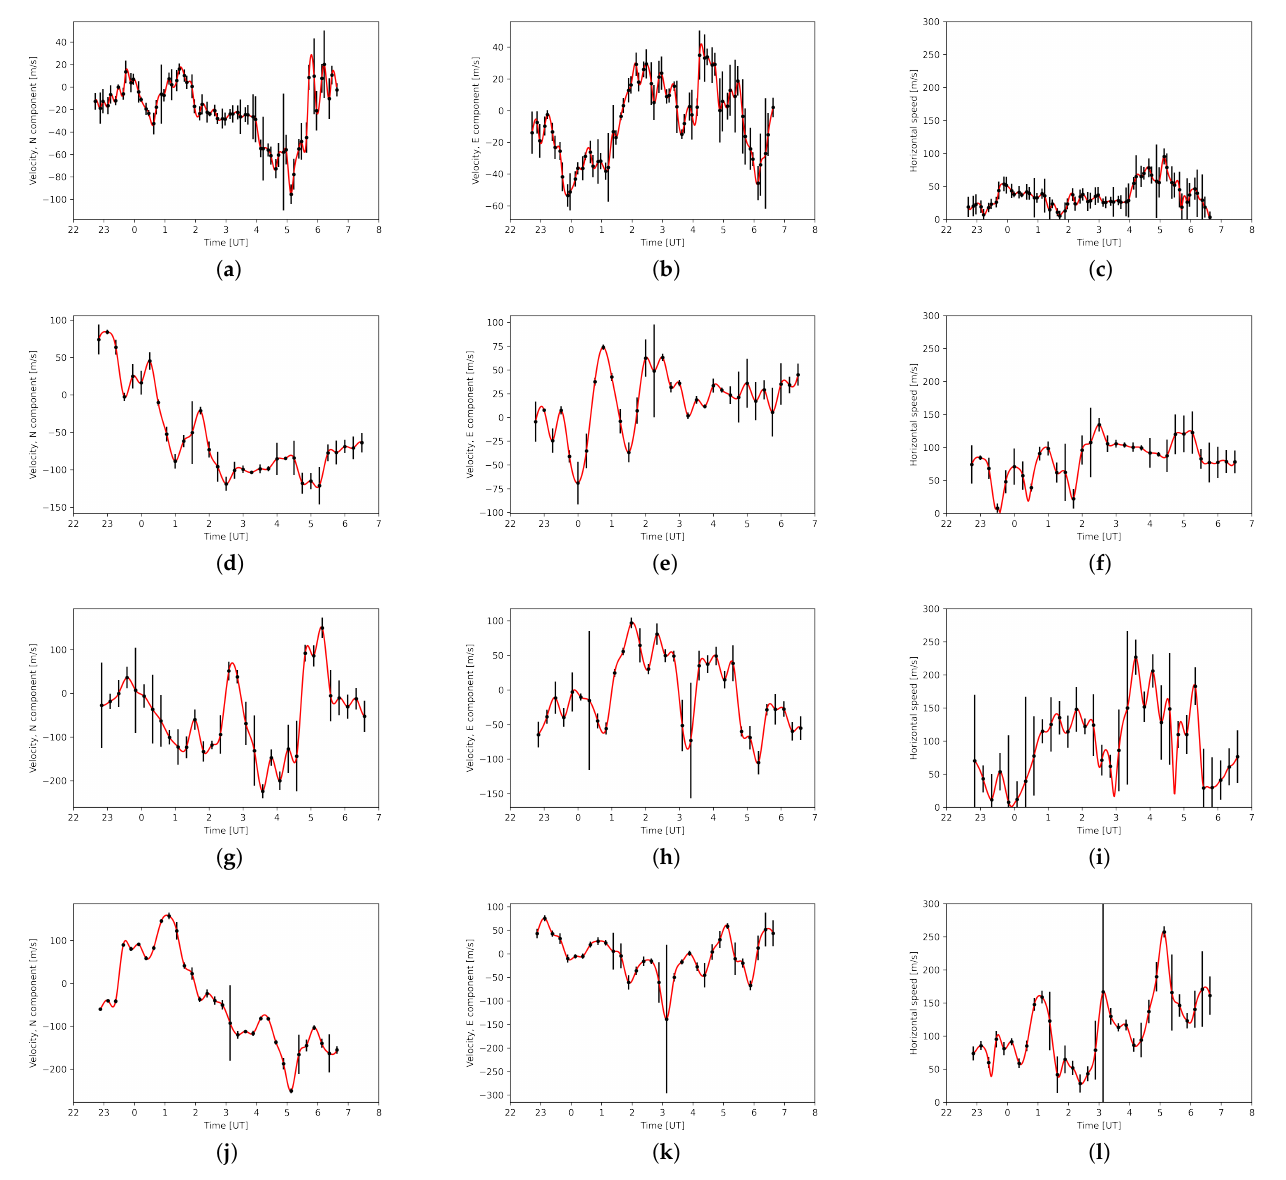
Figure 16. F layer plasma drift velocity data for L79324 with interpolated values (red line) for the North component, East component and horizontal speed of ( a – c ) DB, ( d – f ) JR, ( g – i ) PQ and ( j – l ) FF stations,